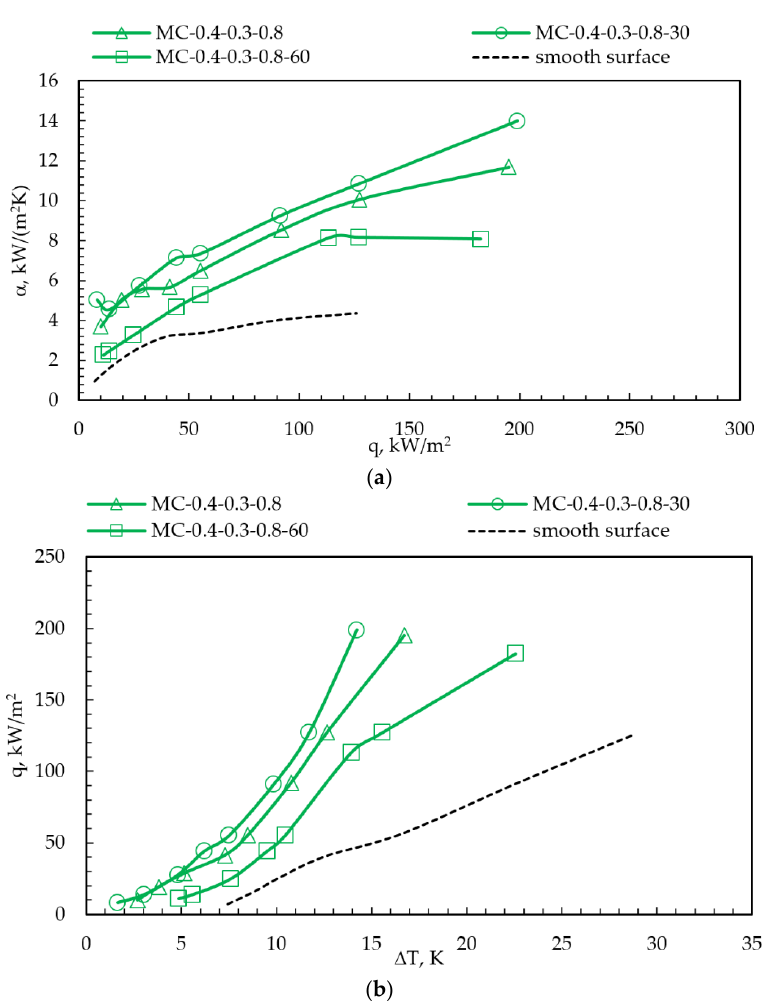
Figure 7. Pool boiling curves for NOVEC-649, width of microchannel 0.4 mm. ( a ) Pool boiling heat transfer; ( b ) boiling